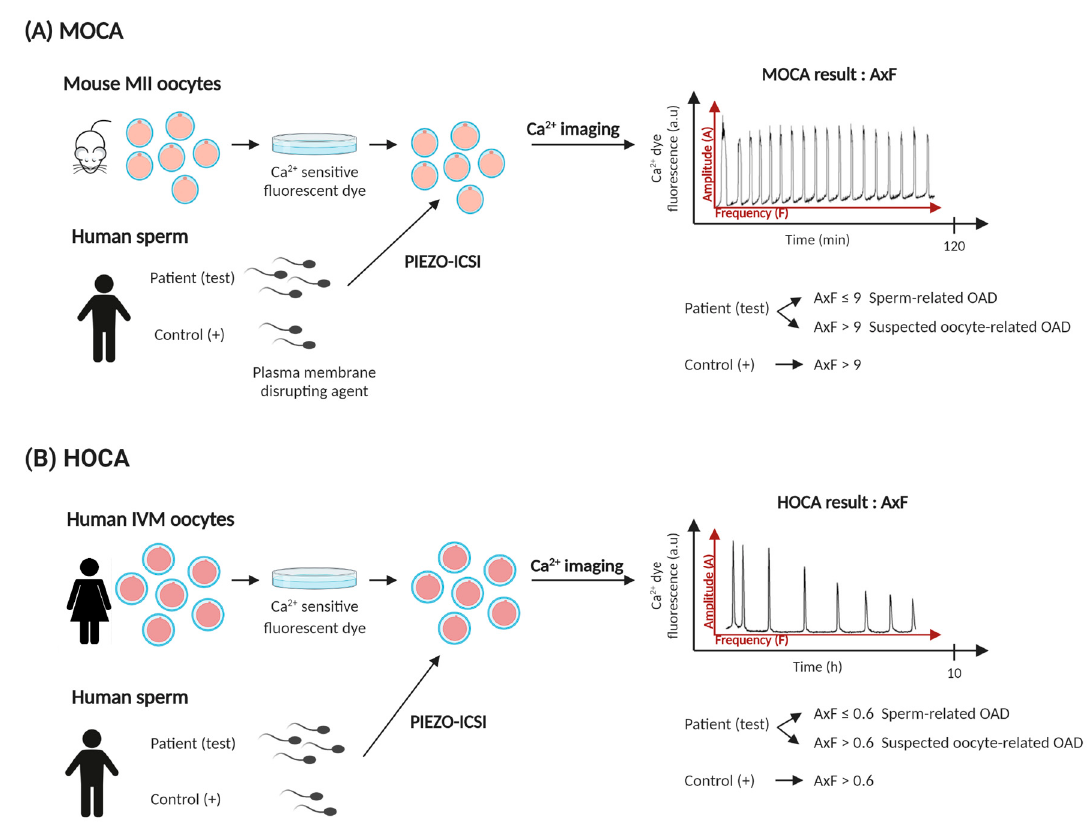
Figure 3. Schematic representation of the diagnostic tests designed to study the calcium (Ca 2 + ) oscillation pattern obtained after injection of human sperm into mouse and human oocytes. ( A ) Mouse oocyte calcium analysis (MOCA). ( B ) Human oocyte calcium analysis (HOCA). ( + ): Positive control group; PIEZO-ICSI: Piezo-assisted intracytoplasmic sperm injection; OAD: oocyte activation deficiency; A: amplitude; F: frequency.